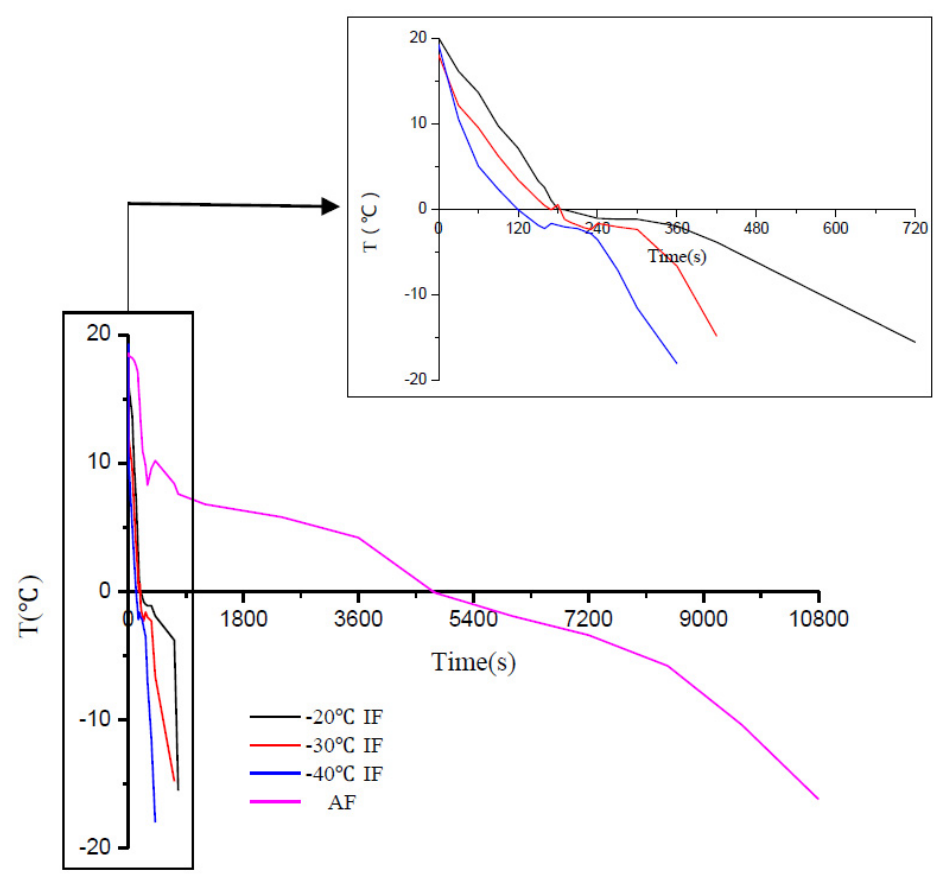
ff erent freezing